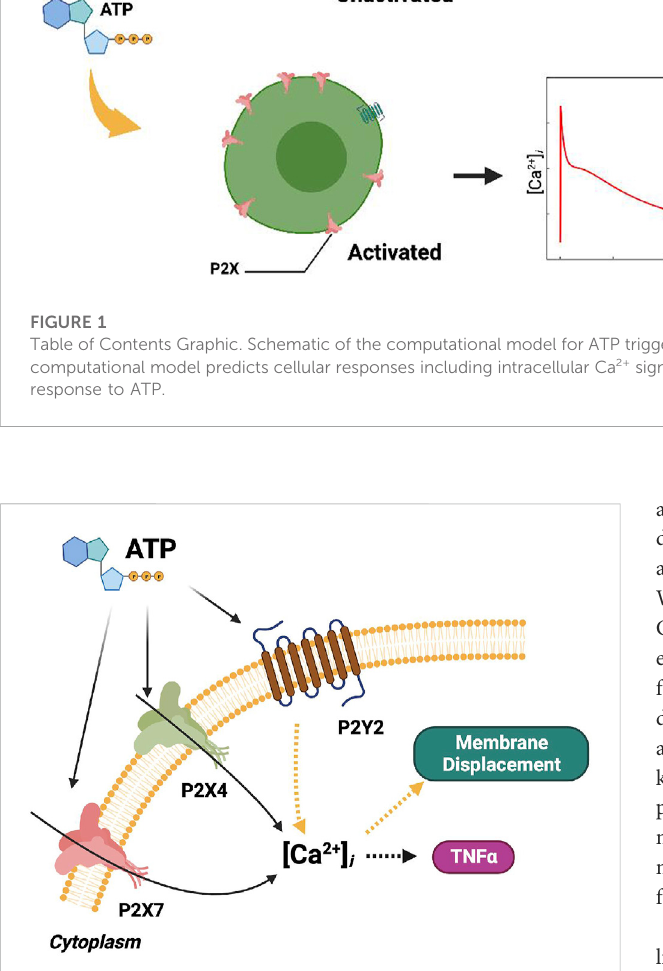
FIGURE 2 Schematic of the computational microglia model, which simulates the ATP-dependent activation of P 2 X - and P 2 Y -class receptors. The simulations also account for increases in intracellular Ca 2+ , cell membrane displacement, and TNF α cytokine production following P2 receptor activation. The pathways modeled in (Chun et al., 2019) for P 2 X signaling are shown in black. The pathways modeled for P 2 Y signaling are shown in yellow. Pathways added in this study are shown in orange. The dashed arrows denote multi-step